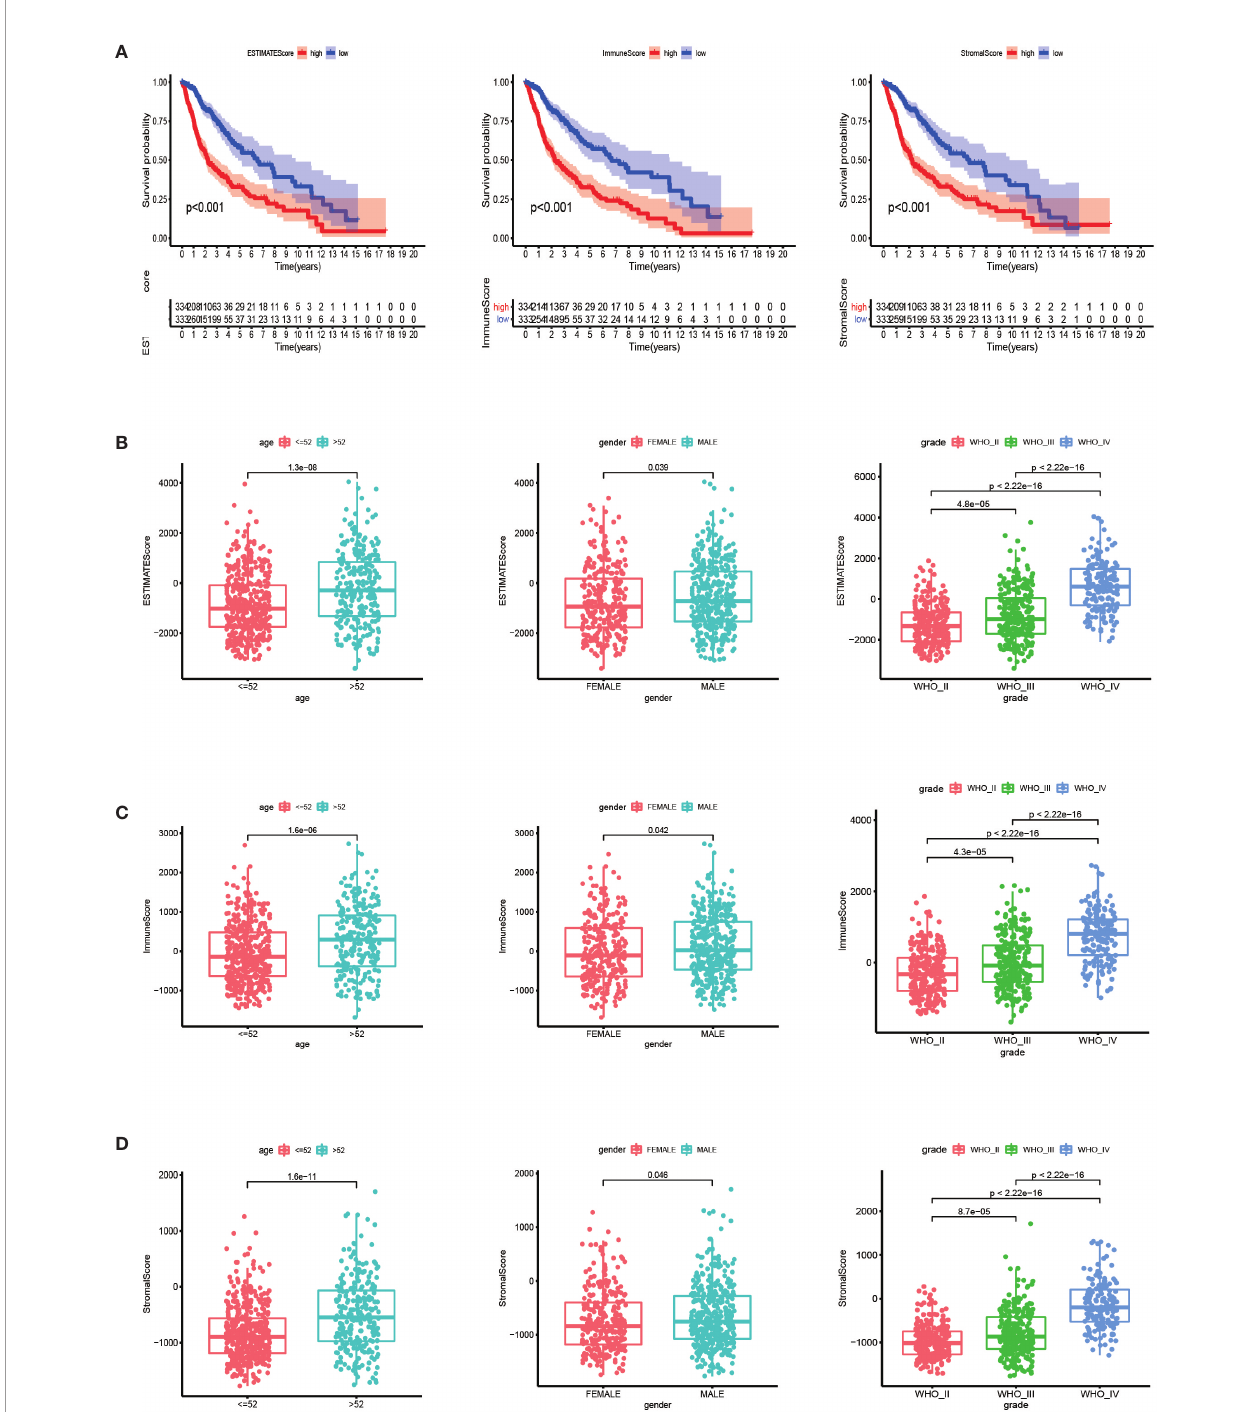
FIGURE 1 | Tumor microenvironment scores are correlated with the survival, age, gender and WHO grade of gliomas. (A) The patients with higher ESTIMATE Score, Immune Score and Stromal Score (p < 0.001) tended to have longer overall survival time. (B) The ESTIMATE Scores were signi fi cantly higher in male, age > 52 years and higher WHO grade patients. (C) The Immune Scores were signi fi cantly higher in male, age > 52 years and higher WHO grade patients. (D) Male, age > 52 years and higher WHO grade patients tended to have higher Stromal